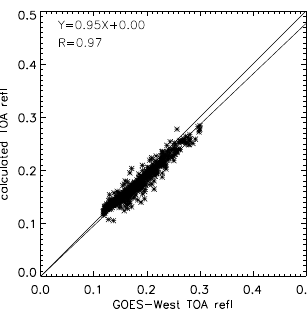
Fig. 14. Scatter plot between calculated TOA reflectance and GOES-West TOA